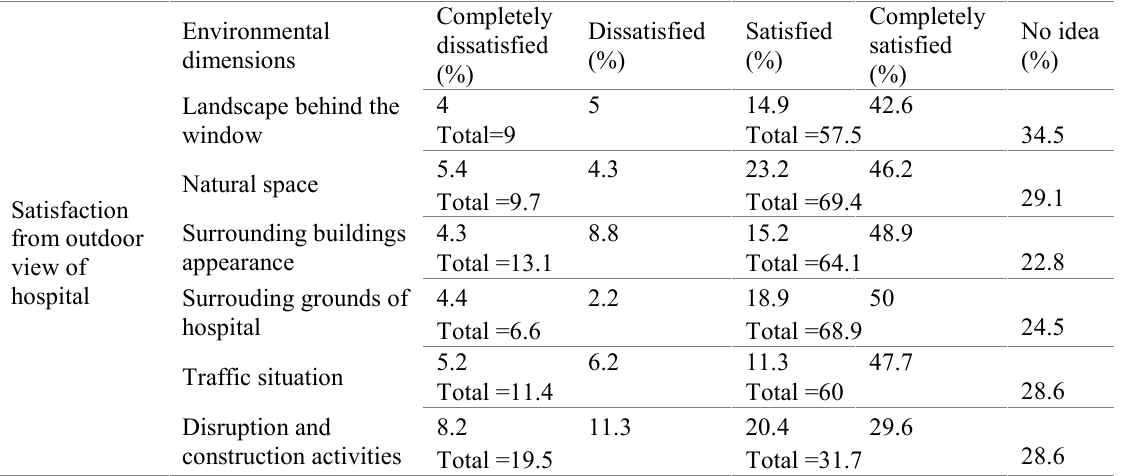
Table1. The patients’ satisfactory experiences from outdoor environmental dimensions in the chosen hospital